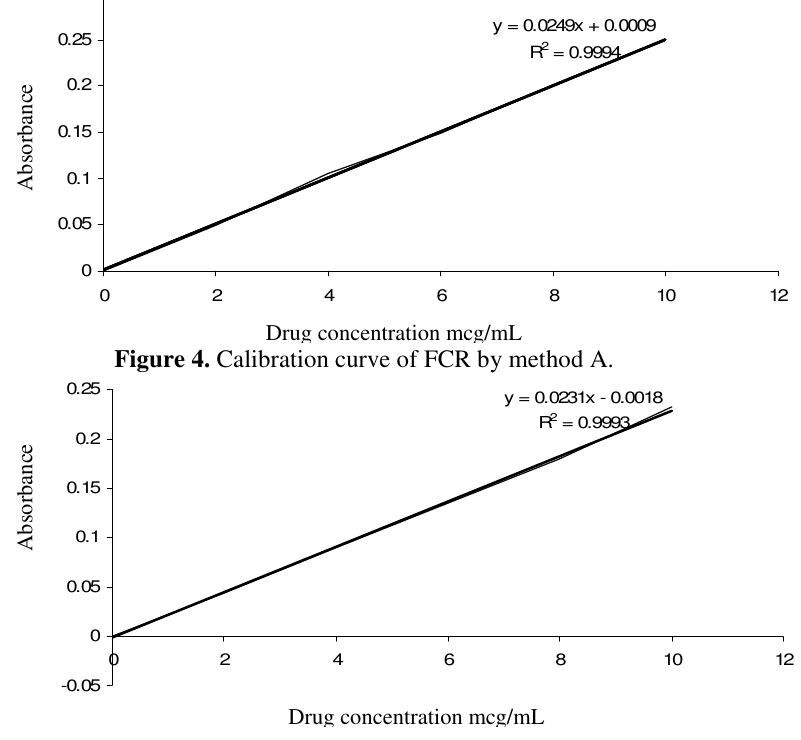
Figure 5. Calibration curve of FCR by method